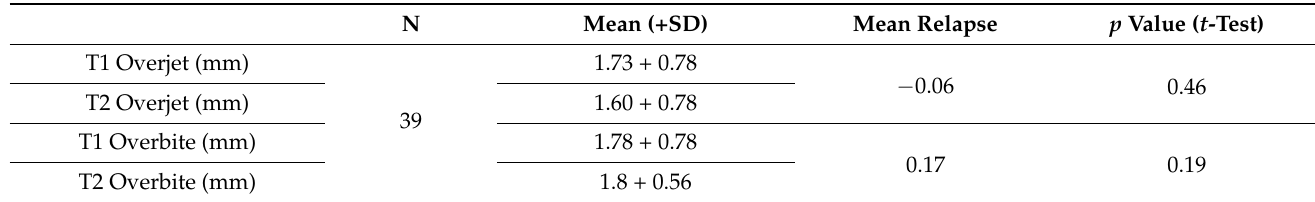
Table 2. Dental stability; Overjet and Overbite movements measurements. N Mean (+SD) Mean Relapse p Value ( t -Test) T1 Overjet (mm) 1.73 + 0.78 − 0.06 0.46 T2 Overjet (mm) 1.60 + 0.78 39 T1 Overbite (mm) 1.78 + 0.78 0.17 1.8 +